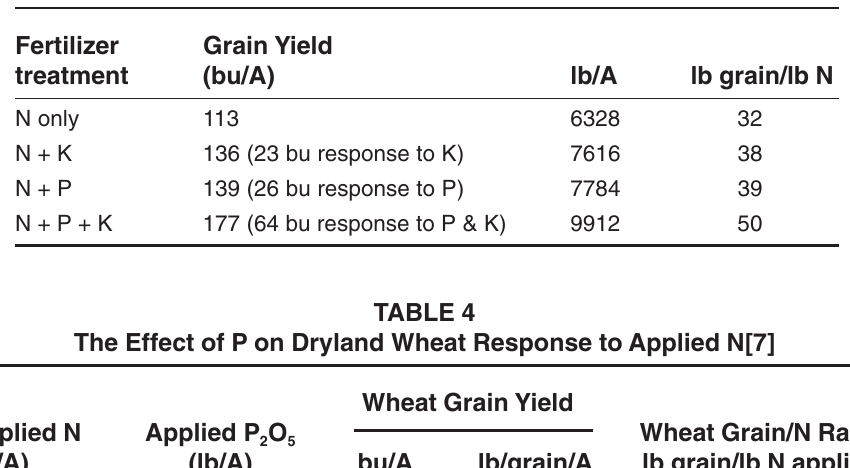
The Influence of P and K on Corn Response to Applied N[6]